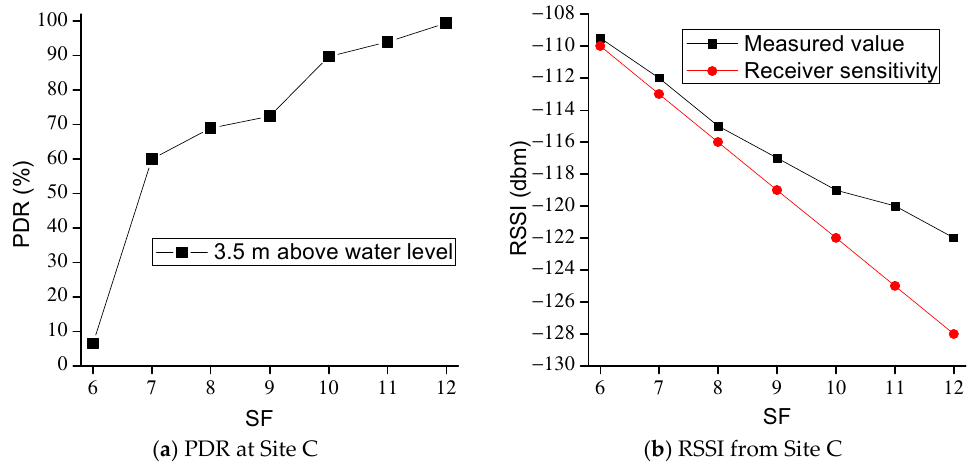
Figure 4. Performance testing at Site C.